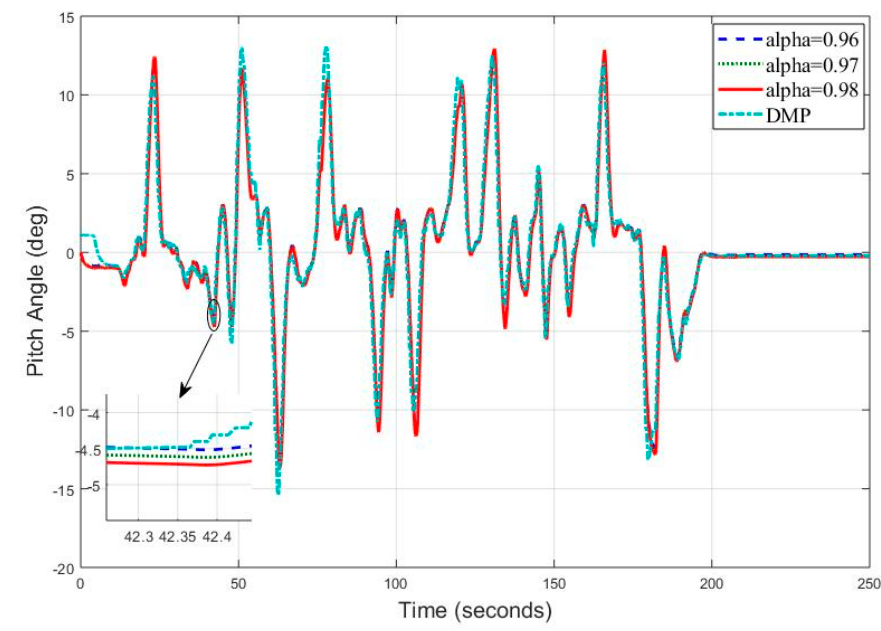
Figure 24. Real Time Pitch Angle Estimate at f = 20 Hz for Complementary Filter.